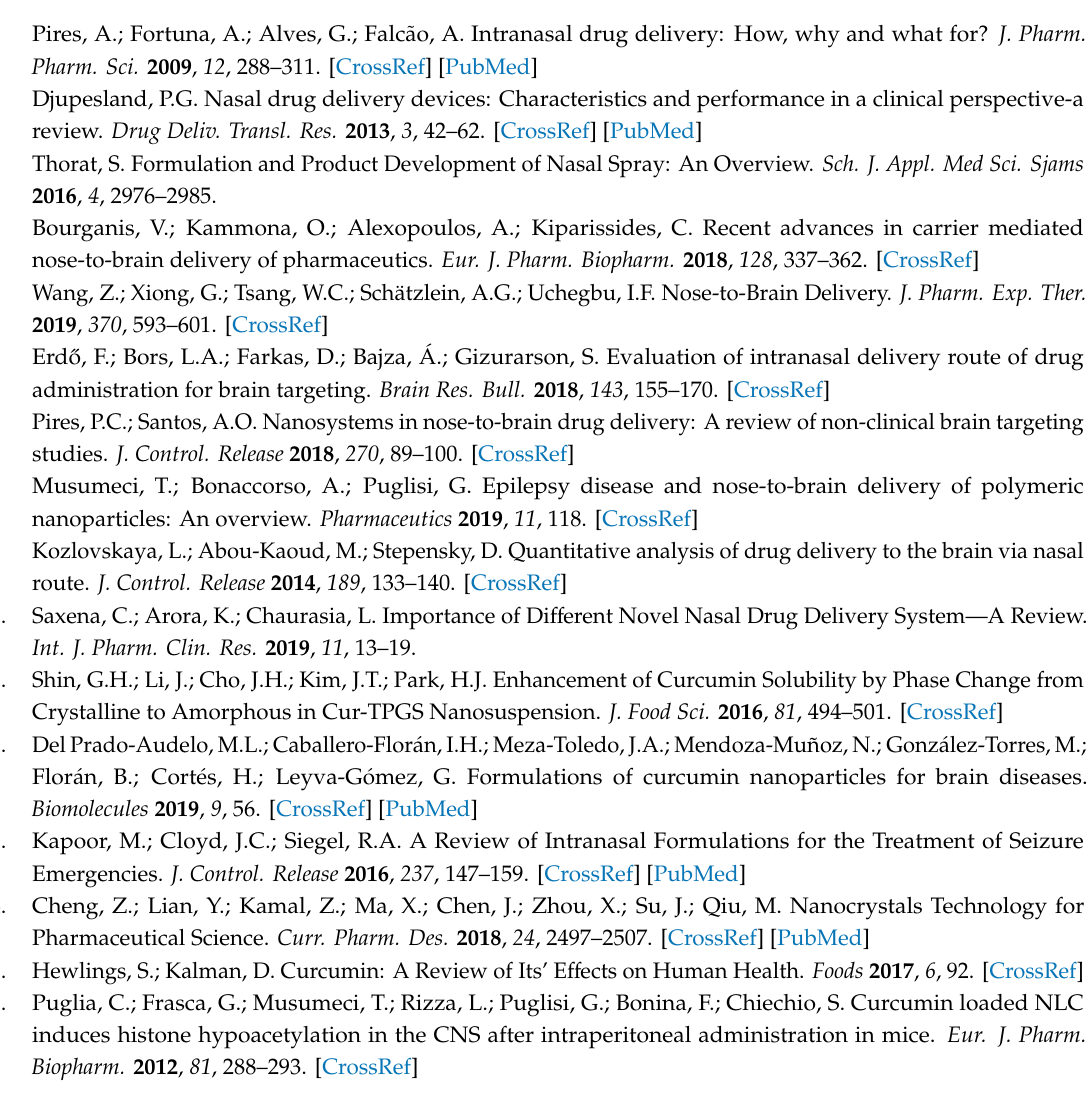
Figure S1: Correlation between predicted and actual values, Figure S2: Desirability of optimized formulation. Figure S3: Size distribution by intensity of redispersed NCs without cryoprotectant (A), with mannitol 5% w / v (B), and with mannitol 10% w / v (C) after freeze-drying